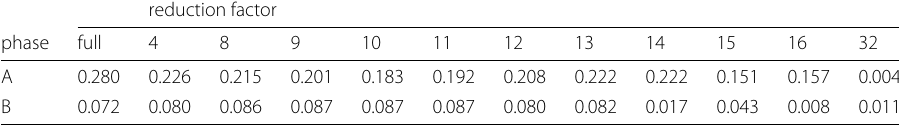
Table 1 Values of the F1 score for the chi square